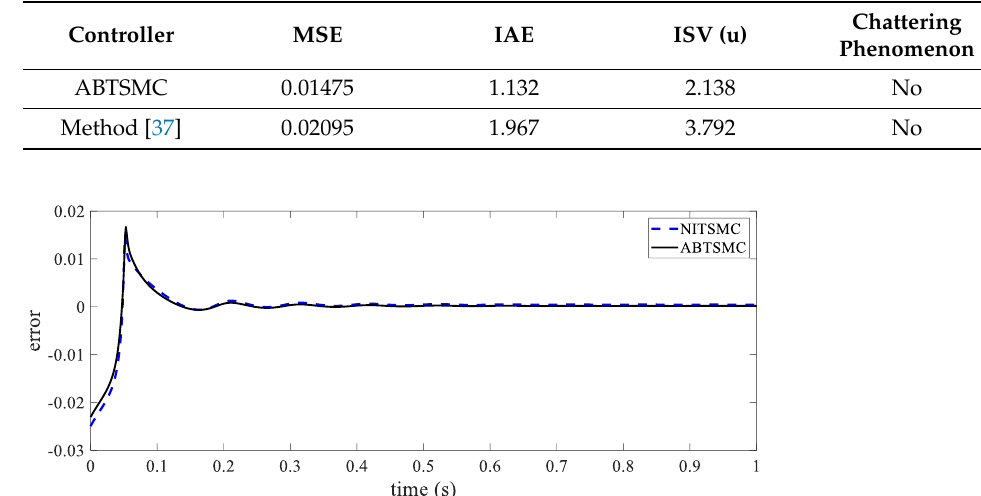
Table 2. Comparison between two control methods.